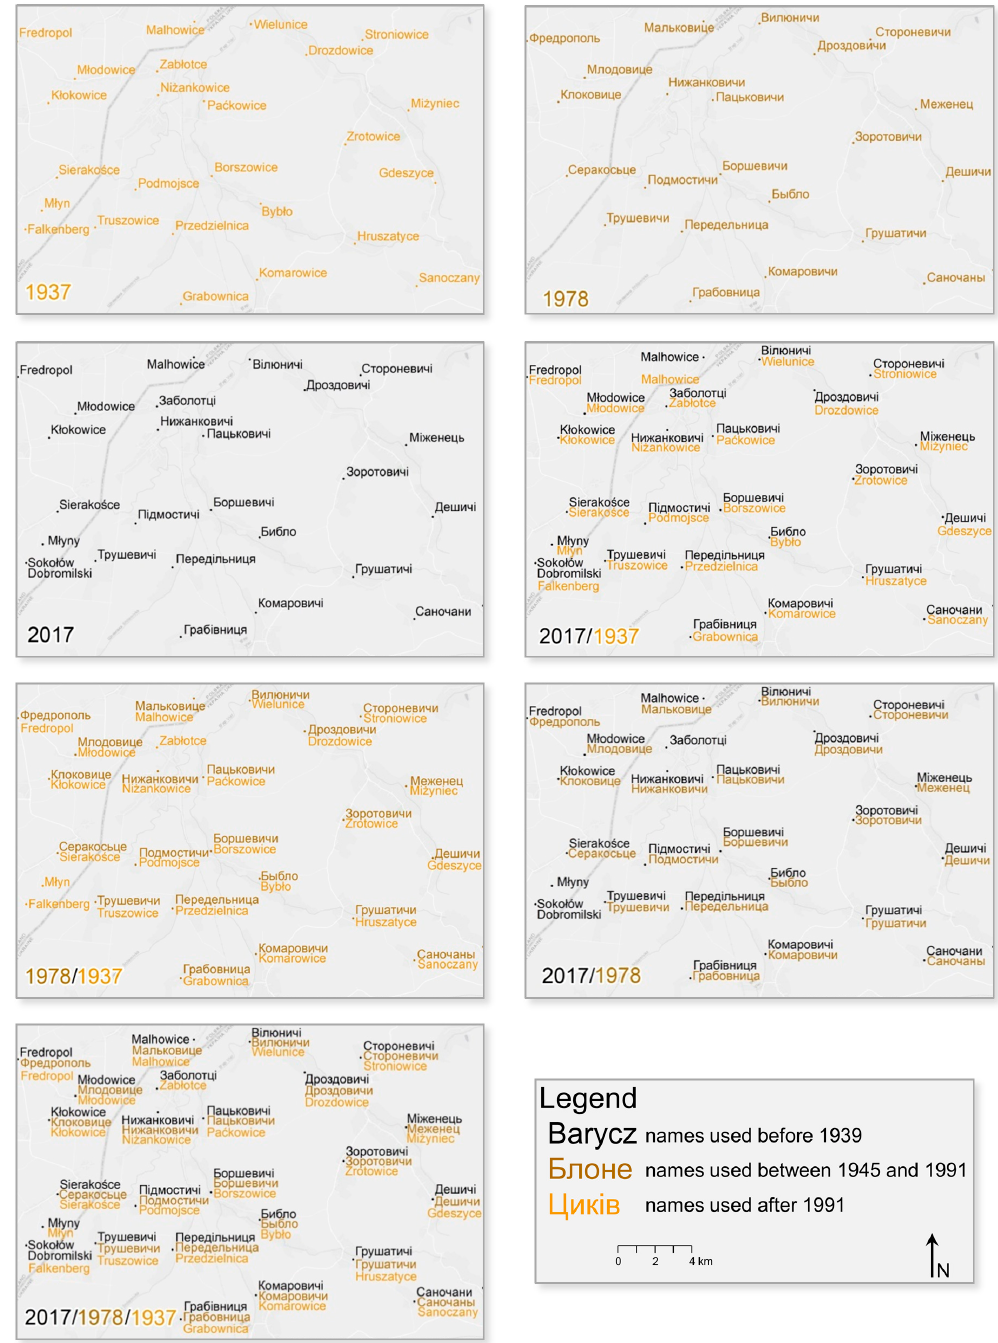
Figure 9. Backgrounds using names for one or few selected time periods (source: own study).